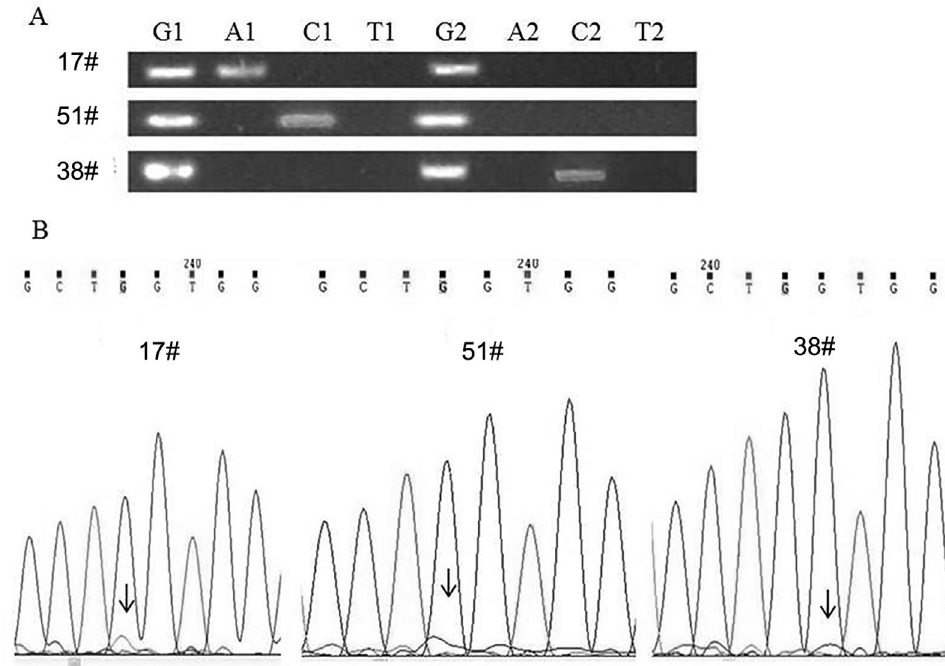
Figure 6 - Mutation detection of the clinical samples. (A) The results of agarose gel electrophoresis for codon 12 of the K-ras gene. (B) Results of the di- rect sequencing. G, A, C and T represent the four reactions corresponding to each pair of detection